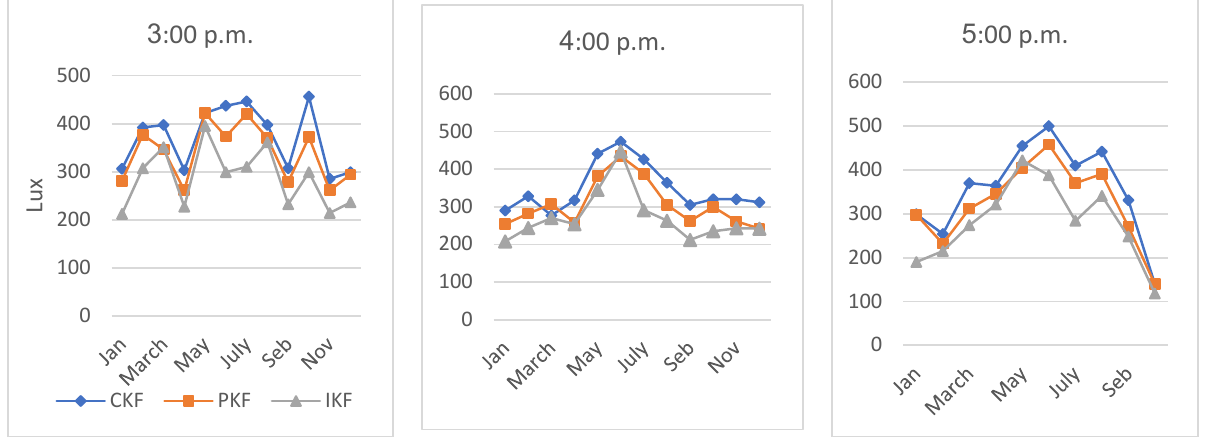
Figure 7. The contrasts (difference between maximum and minimum illuminance) for the three proposed systems.